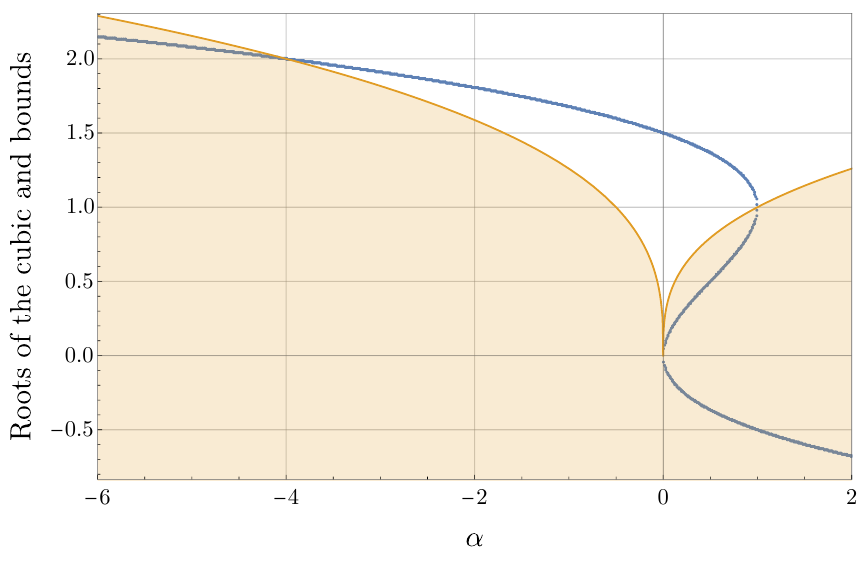
Figure 1 . The roots of the cubic (4.40) with respect to the parameter α